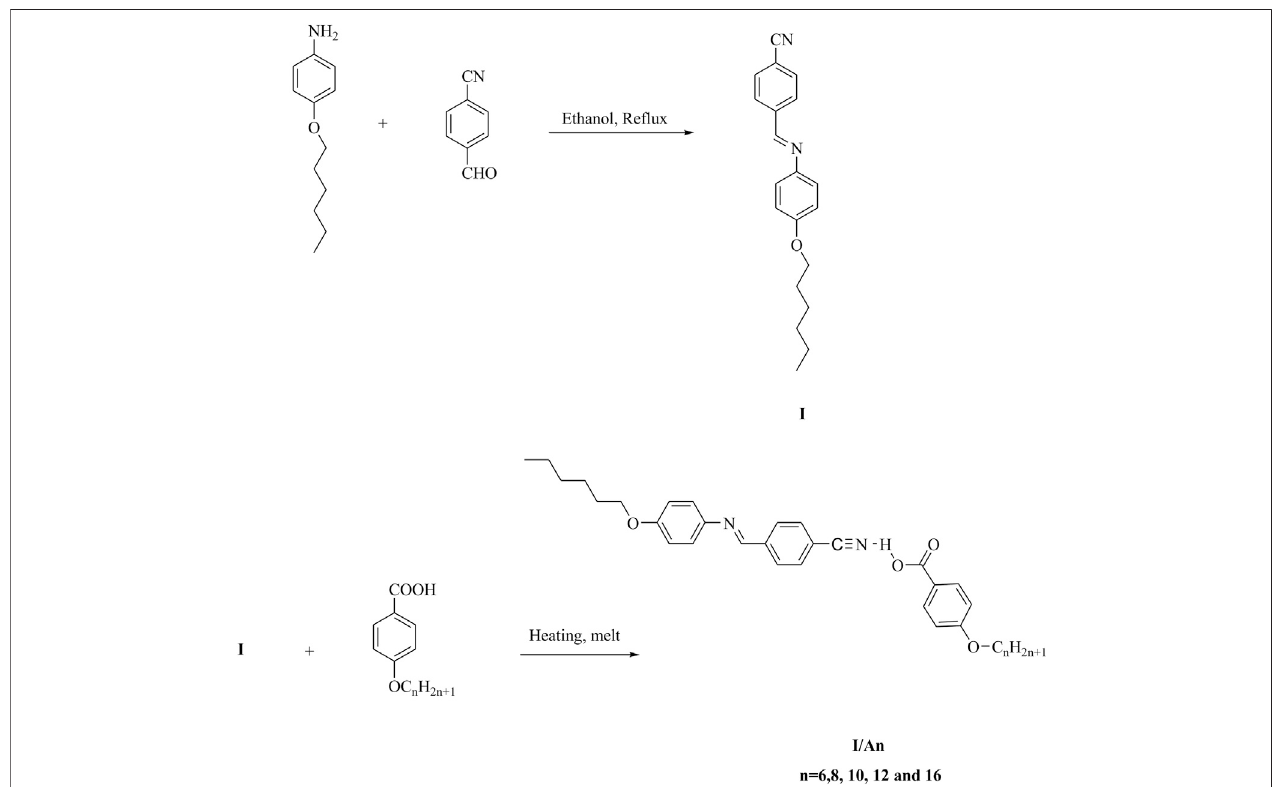
FIGURE 1 | Synthesis of 1:1 SMHBCs I/An.